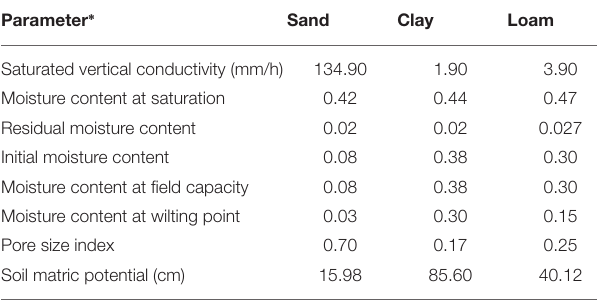
TABLE 2 | ICPR vadose zone soil